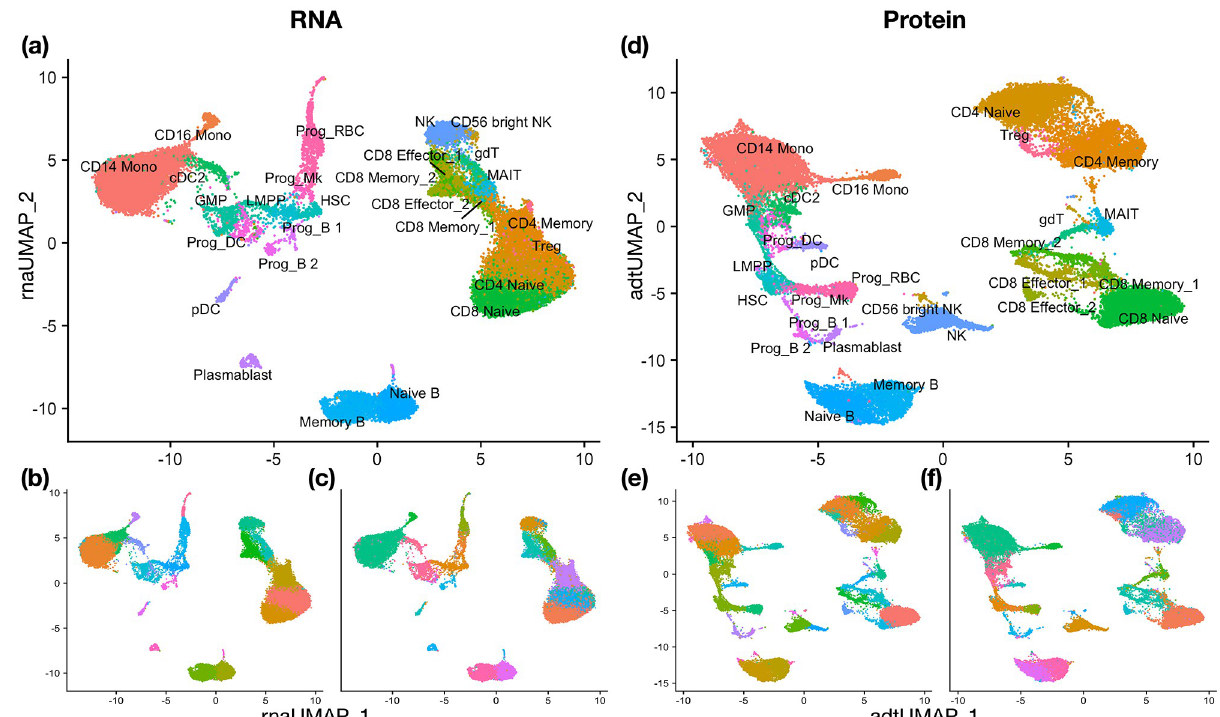
Fig 3. UMAP visualization for HBMC data and the clustering results. (a) True clusters on RNA. (b) Single-view clustering result on RNA. (c) CPS- merge analysis result on RNA. (d) True clusters on Protein (ADT). (e) Single-view clustering result on Protein (ADT). (f) CPS-merge analysis result on Protein